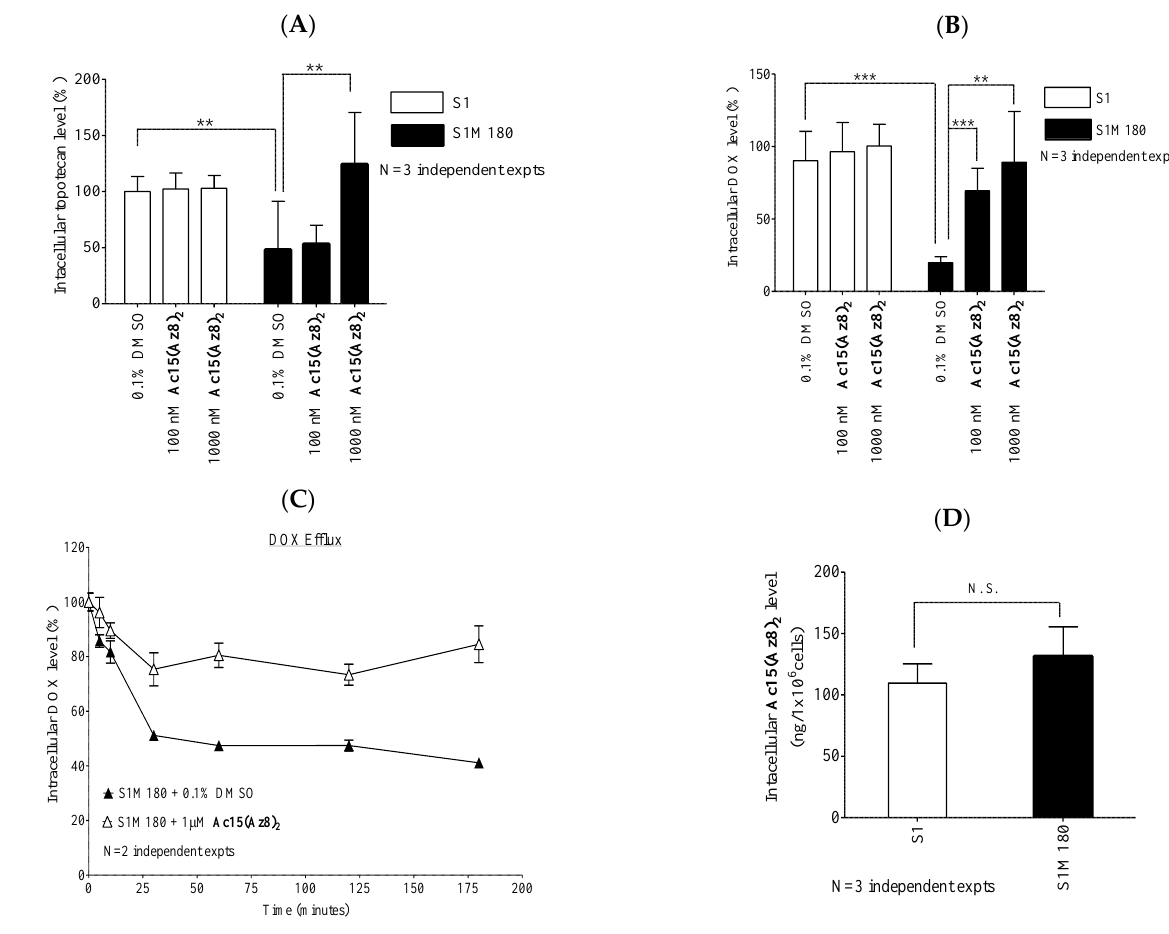
Figure 2. Effect of Ac15(Az8) 2 on intracellular accumulation of BCRP-substrates in S1 and S1M180 cells. Cells were pre-treated with 0.1% DMSO, 100 nM, or 1000 nM Ac15(Az8) 2 and then incubated with BCRP substrates. ( A ) Topotecan accumulation. ( B ) DOX accumulation. The intracellular level of drug after treatment was normalized to that of S1 cells after incubating with 0.1% DMSO. Student unpaired two-tailed t-test was conducted as indicated (** p < 0.01, *** p < 0.001). ( C ) To measure DOX efflux, S1M180 cells were pre- incubated with medium containing 20 μM DOX for 1 h at 37 °C. Cells were then washed and further incubated with or without 1 µM of Ac15(Az8) 2 . At 0, 5, 10, 30, 60, 120, and 180 min, the cells were harvested to measure the intracellular DOX level. ( D ) To determine intracellular Ac15(Az8) 2 concentration, 1 × 10 7 cells were incubated with 1 µM of Ac15(Az8) 2 at 37 °C for 2 h. Cells were then washed with ice-cold PBS. To the cell pellet, acetonitrile was added to lyse the cells, and the supernatant was saved for Ac15(Az8) 2 determination using UPLC – MS/MS. All values in this figure were presented as mean ± S.D. N.S. = not significant. 2.3. Ac15(Az8) 2 Does Not Affect the Cell Surface BCRP Level Flow cytometry study indicated that cell surface BCRP was found in HEK293/R2 but not in HEK293/pcDNA3.1 cells (Figure 4A). Quantitatively, there was about 32–36-fold more cell surface BCRP in HEK293/R2 cells compared to that of HEK293/pcDNA3.1 (Figure 4B). Treatment with Ac15(Az8) 2 for 24 or 72 h slightly increased cell surface BCRP level in HEK293/R2 by 10–20% (Figure 4B). Together, this result suggested that Ac15(Az8) 2 did not significantly affect cell surface BCRP